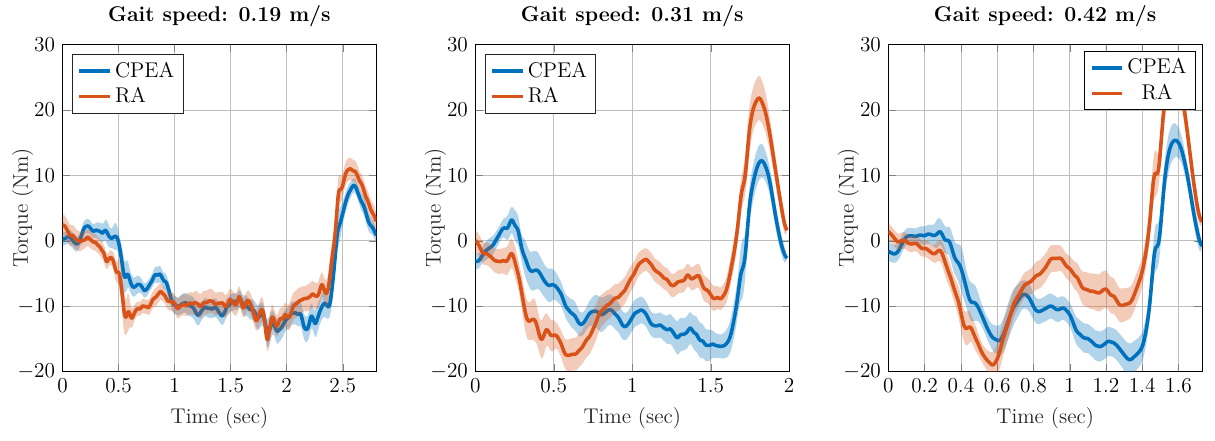
Figure 14. Joint torque for the hip at three different gait velocities for an RA and CPEA. We recall that the power consumption of the motor can be calculated from the motor current and the motor voltage, which is the sum of the ohmic losses and the induced voltage